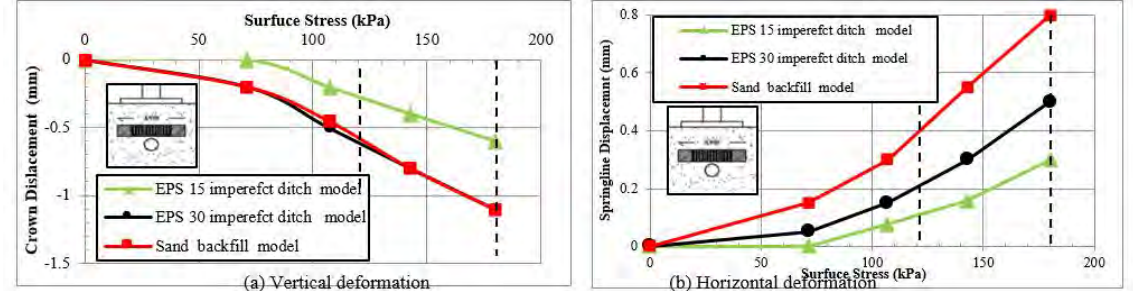
Figure 7. Deformationof UPVC buried pipe under embedded EPS blocks (Imperfect Ditch)